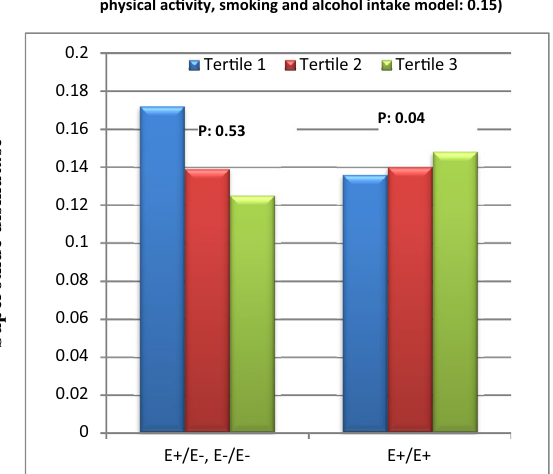
Figure 6. Interaction between Apo B EcoR1 SNP and HEI-2015 on serum superoxide dismutase level.